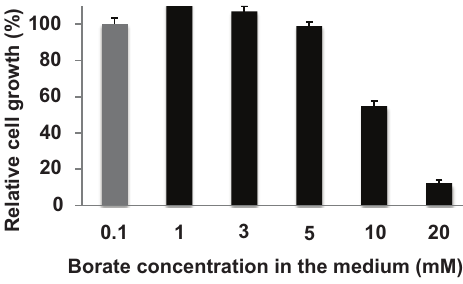
Figure 2. Effect of borate on the growth of BY-2 cells. Seven-day old tobacco BY-2 cells were subcultured into medium containing the indicated concentration of borate and shaken for a week. The volume of cells in the culture was measured. Gray bar; standard borate concentration medium. Error bars, SD.